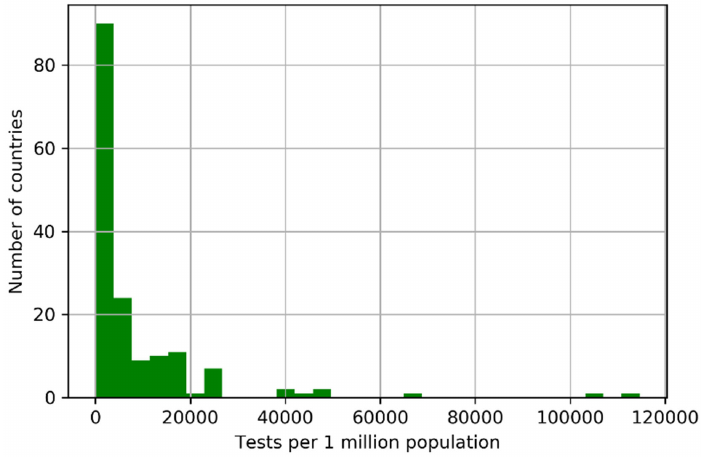
Figure 9. After more than 12 weeks since the WHO declared COVID-19 a pandemic, we still do not have accurate statistics. Only a few countries have conducted well-designed statistical experiments to estimate the true values of C, D, and